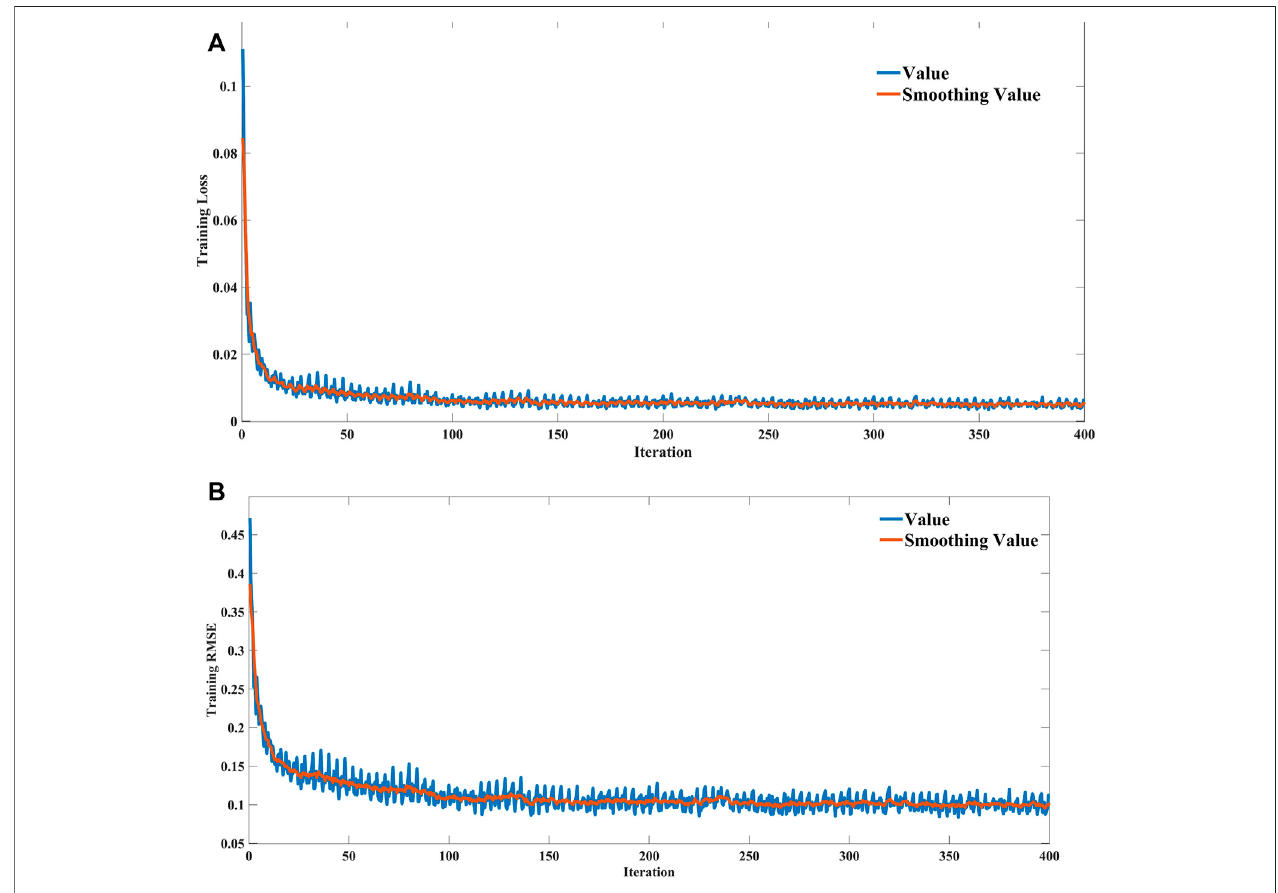
FIGURE 6 | Train processes. (A) Training loss; (B) training